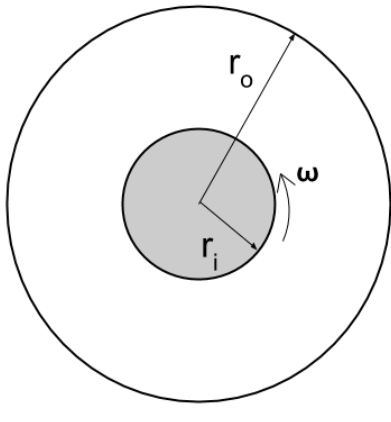
Figure 5. Circular Couette flow.